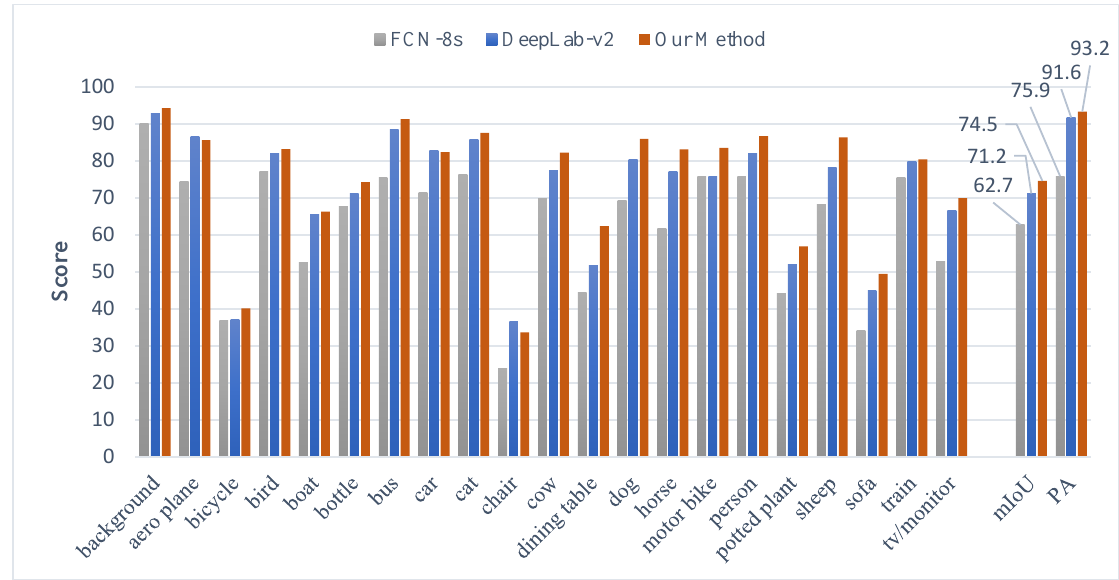
Figure 12. IoU, mIoU, and PA scores on the PASCAL VOC 2012 dataset.